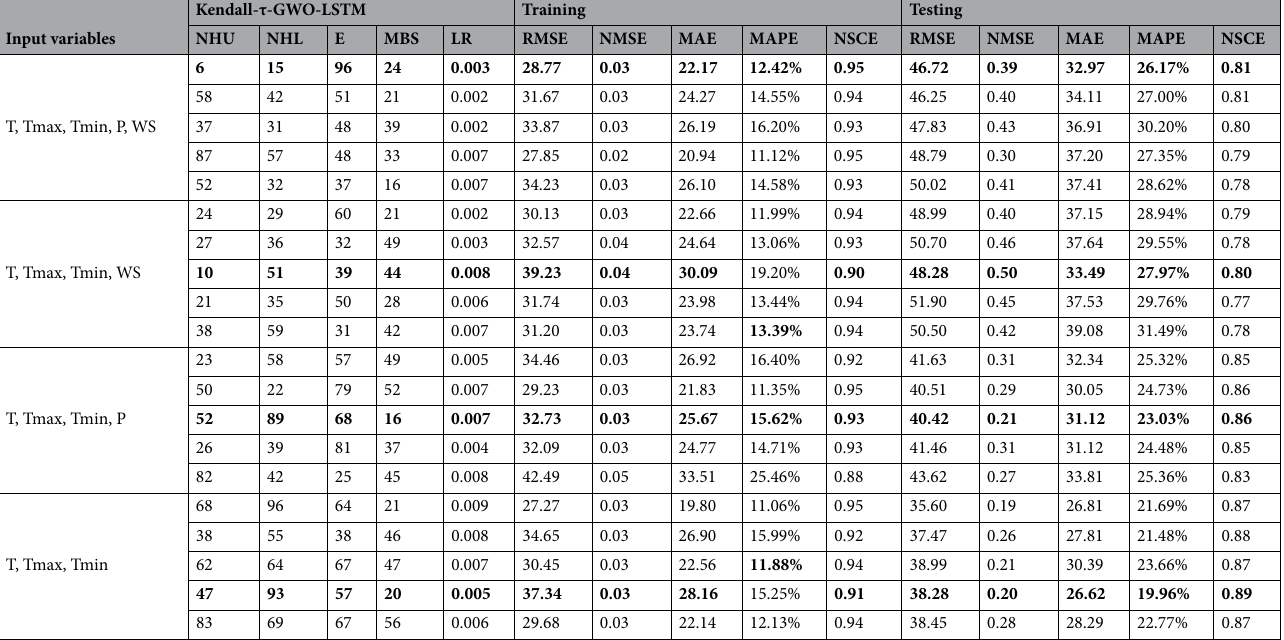
Table 7. The optimal hyper-parameters and model performance of Kendall-τ-GWO-LSTM. The optimal hyper-parameters and evaluation metrics of the hybrid Kendall-τ-GWO-LSTM model are marked in